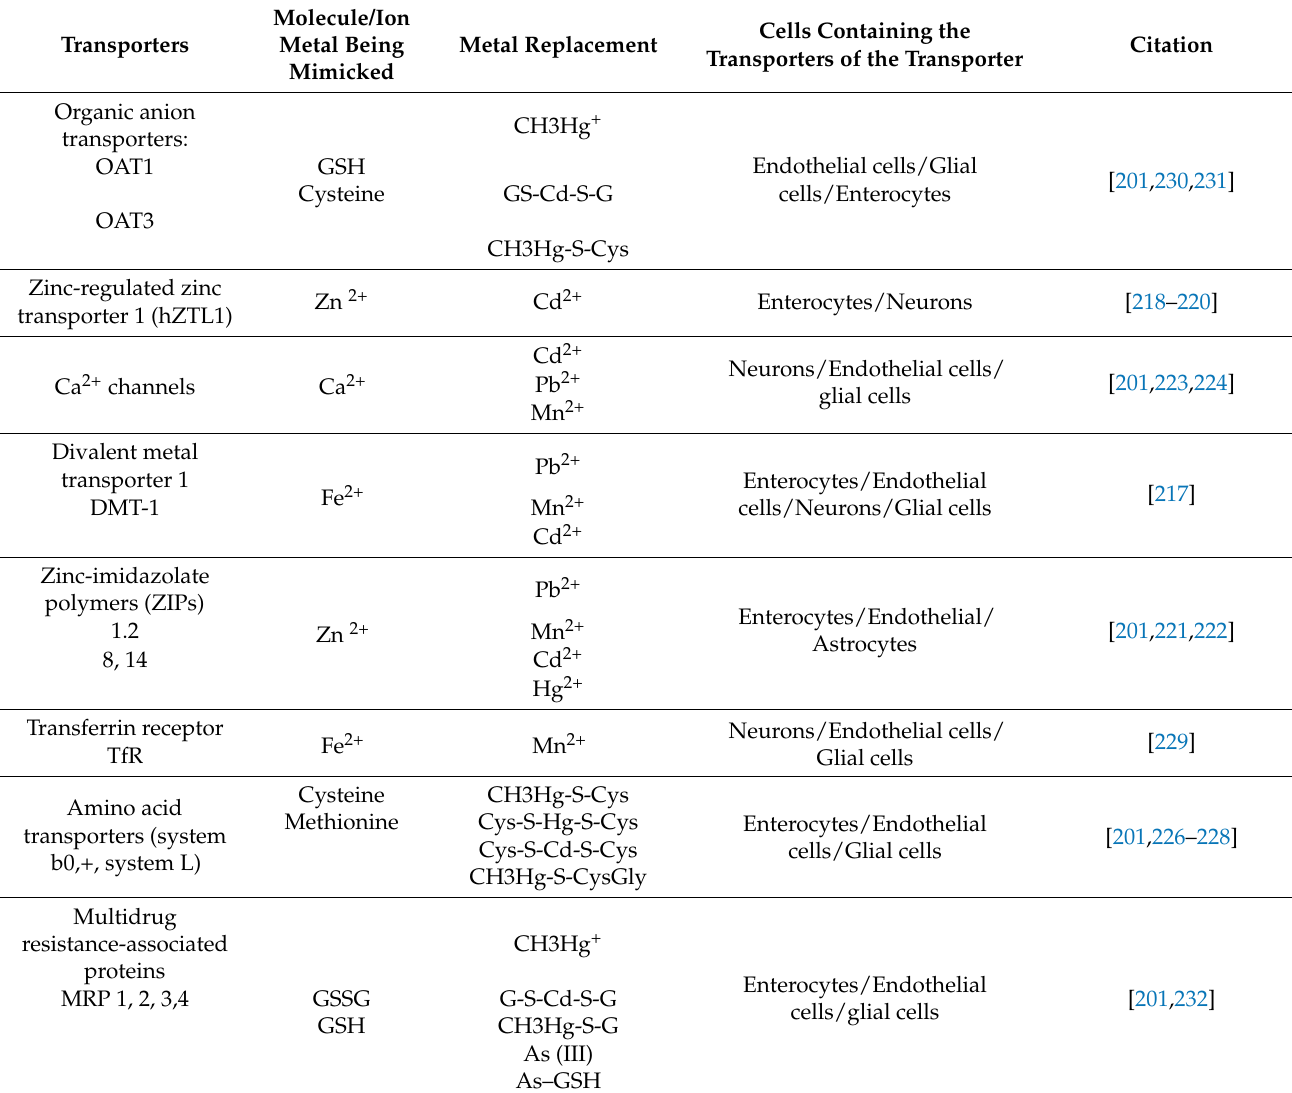
Table 1. Molecular mimicry of metals throughout the gut–brain